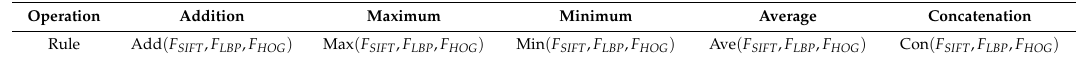
Table 1. Feature fusion rules of different fusion operations.